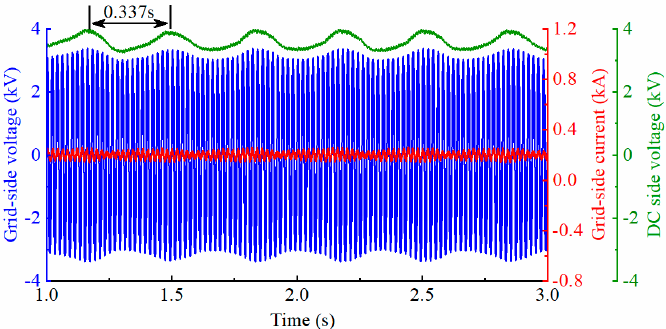
Figure 18. Grid-side voltage and current waveforms when five CRH5s are connected.